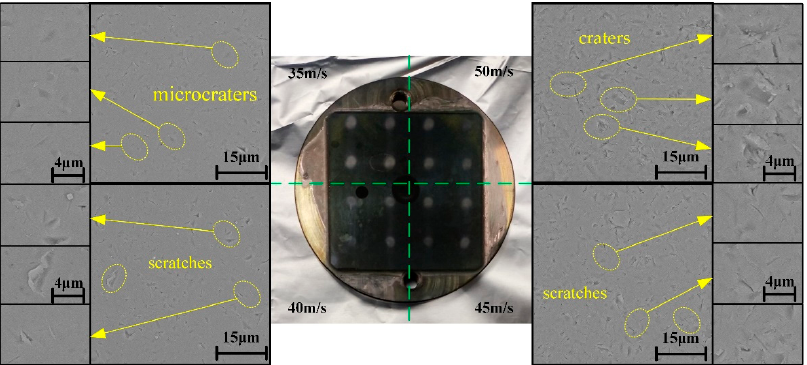
Figure 3. Surface morphology of impacted optical glass under different impact speeds.